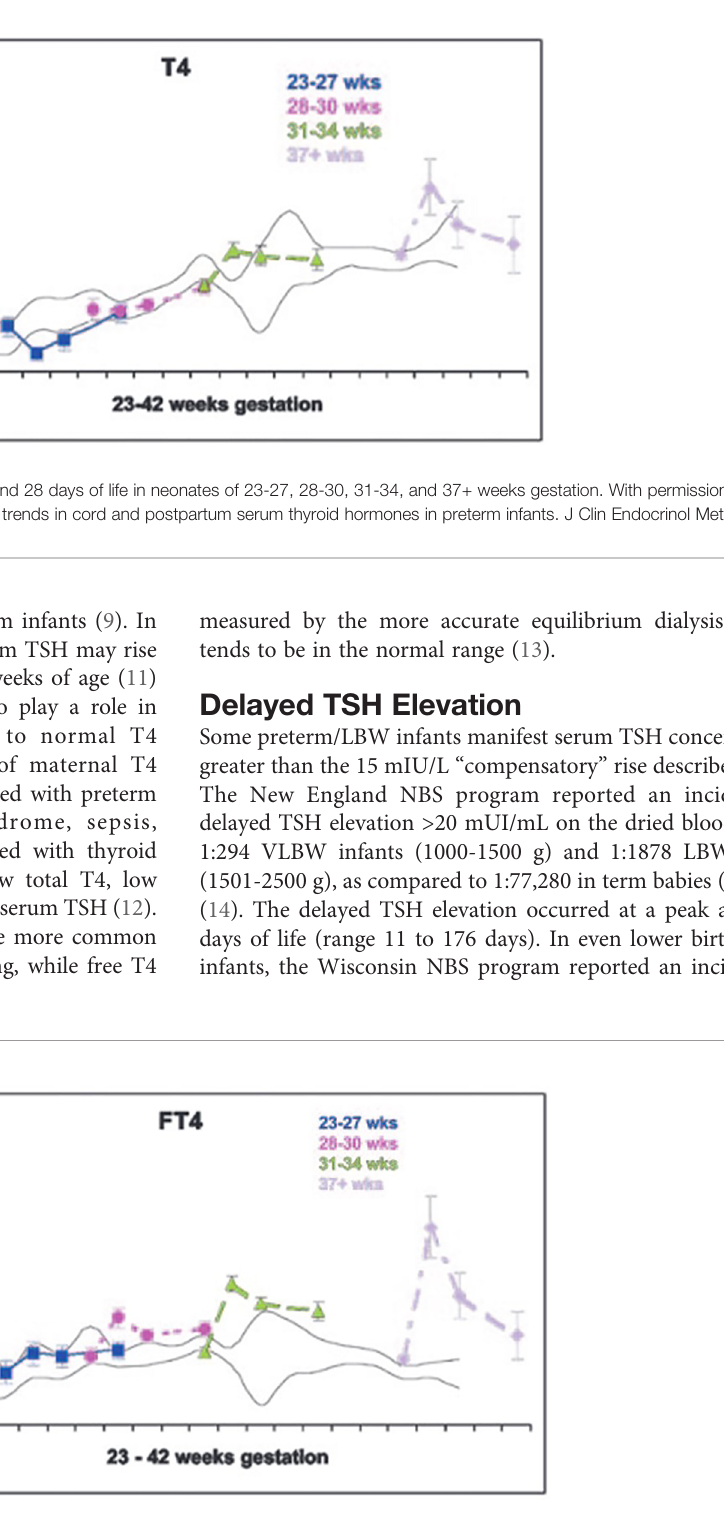
FIGURE 3 | Serum free T4 levels in cord blood, and at 7, 14 and 28 days of life in neonates of 23-27, 28-30, 31-34, and 37+ weeks gestation. With permission from Williams FL, Simpson J, Delahunty C, et al. Developmental trends in cord and postpartum serum thyroid hormones in preterm infants. J Clin Endocrinol Metab 2004; 89:5314-5320 (9).